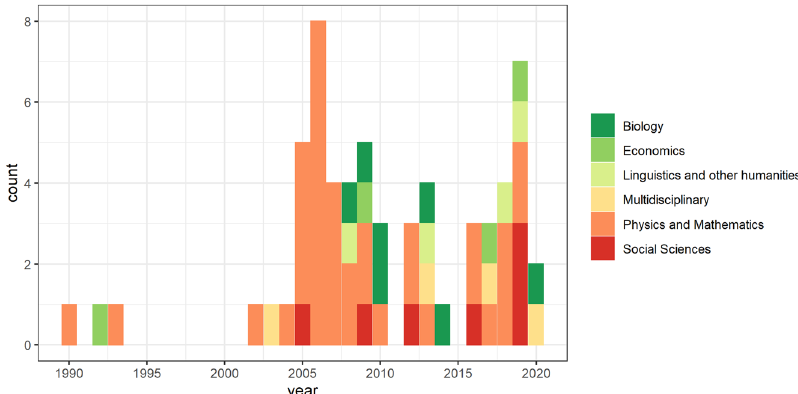
Fig. 3 Study breakdown by year and main discipline of journal of publication. Disciplines are based on Scopus ’ Subject area classi fi cation. Disciplines were merged into a reduced number of categories to facilitate interpretation (see Table S3 of the supplementary